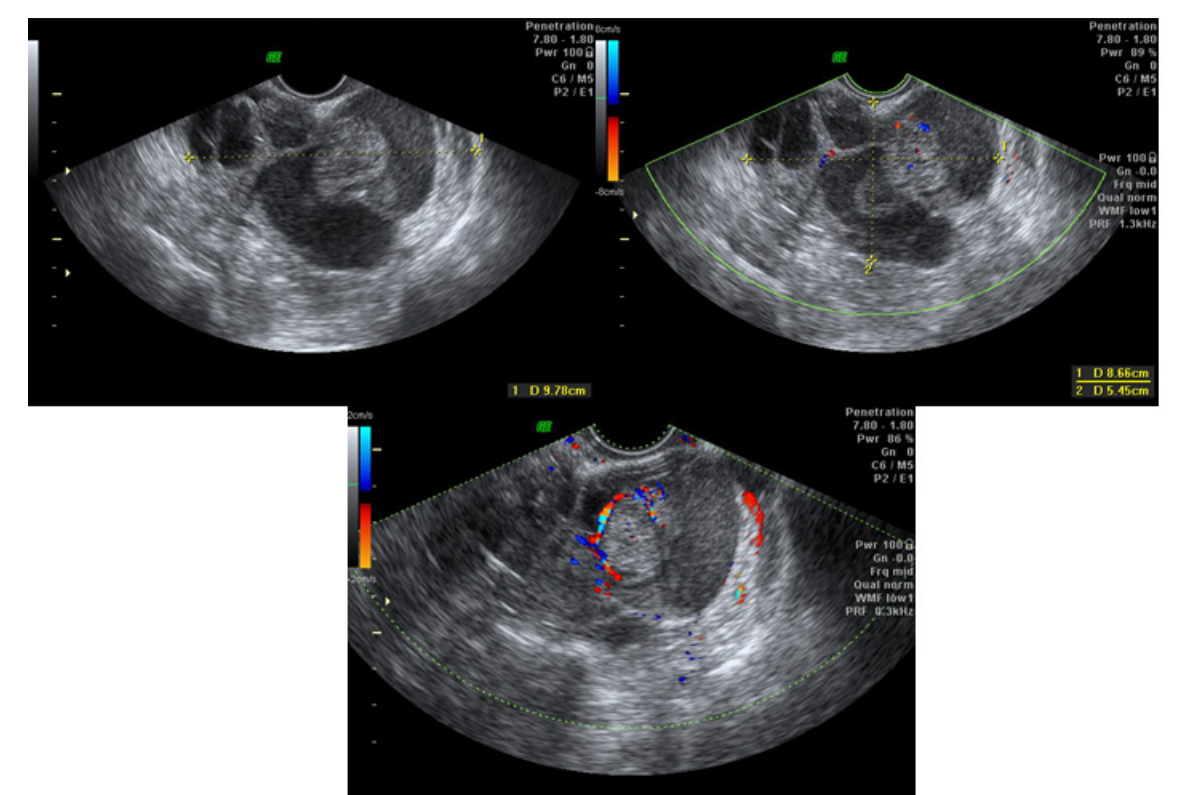
Figure 2. Case number 1; 46 years old woman, presented with dysmenorrhea, infertility (11 cycles of IVF), 1 parity. CA125 = 30. On TVUS multilocular cyst with high suspicious of malignancy, hystological result was borderline mucinous tumor.